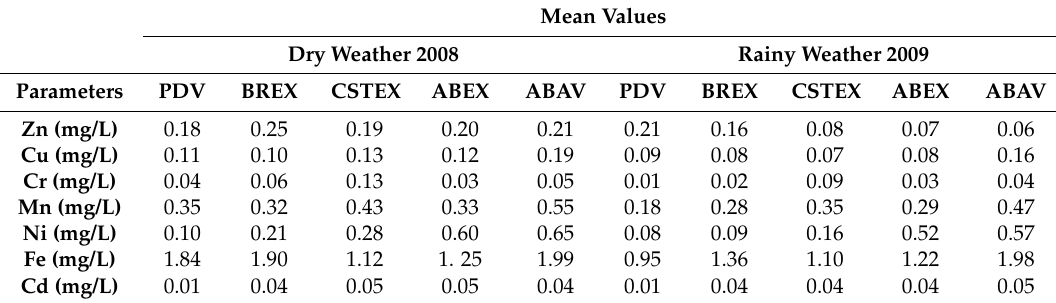
Table 1. Mean metal values from the sampling points.